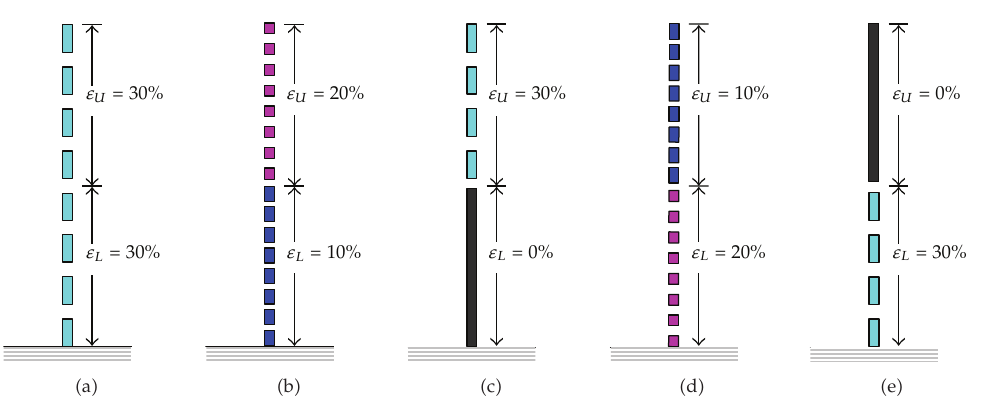
Figure 6: Porous fences: (cid:7) a (cid:8) ε U (cid:3) 30% and ε L (cid:3) 30%; (cid:7) b (cid:8) ε U (cid:3) 20% and ε L (cid:3) 10%; (cid:7) c (cid:8) ε U (cid:3) 30% and ε L (cid:3) 0%; (cid:7) d (cid:8) ε U (cid:3) 10% and ε L (cid:3) 20%; (cid:7) e (cid:8) ε U (cid:3) 0% and ε L (cid:3) 30%.